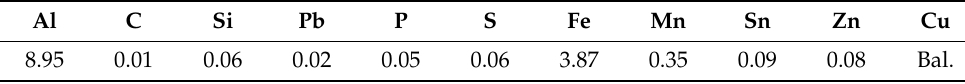
Table 1. The chemical composition of C61900 Cu alloy (wt.%).